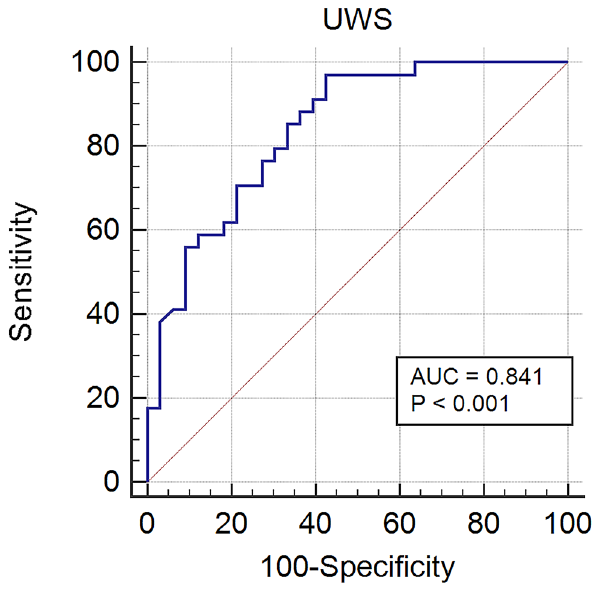
Figure 3. The receiver operating characteristic curve (ROC) for distinguishing patients with oral squamous cell carcinoma from healthy individuals based on values in unstimulated whole saliva (UWS) ( AUC area under curve; blue line—melatonin (pg/ml); red line—reference